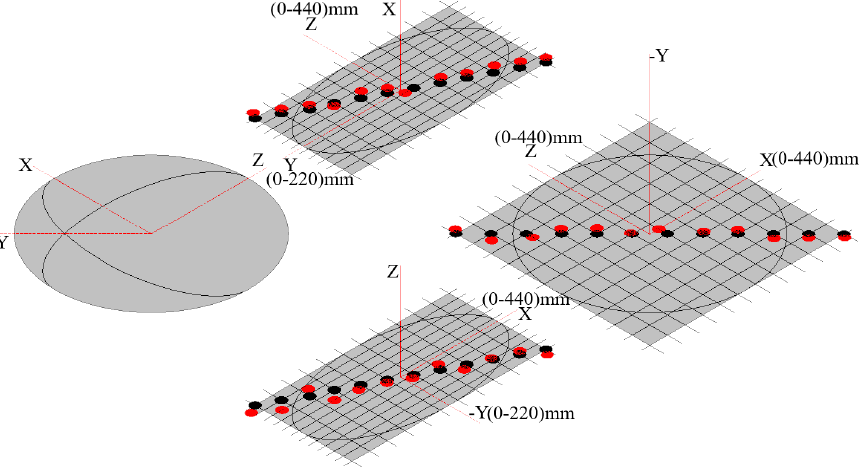
Figure 14. Integrated geometric errors of machining points (3D view).